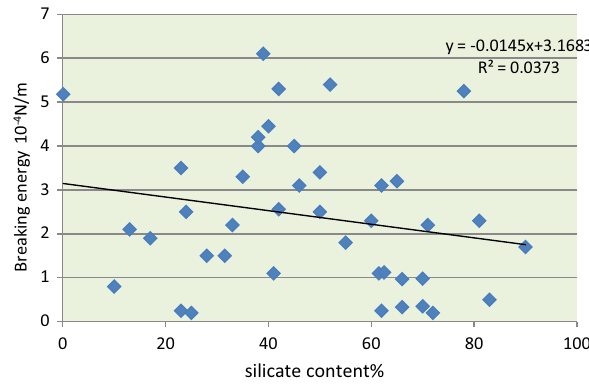
Fig. 5 Relationship between breaking energy and Young’s modulus